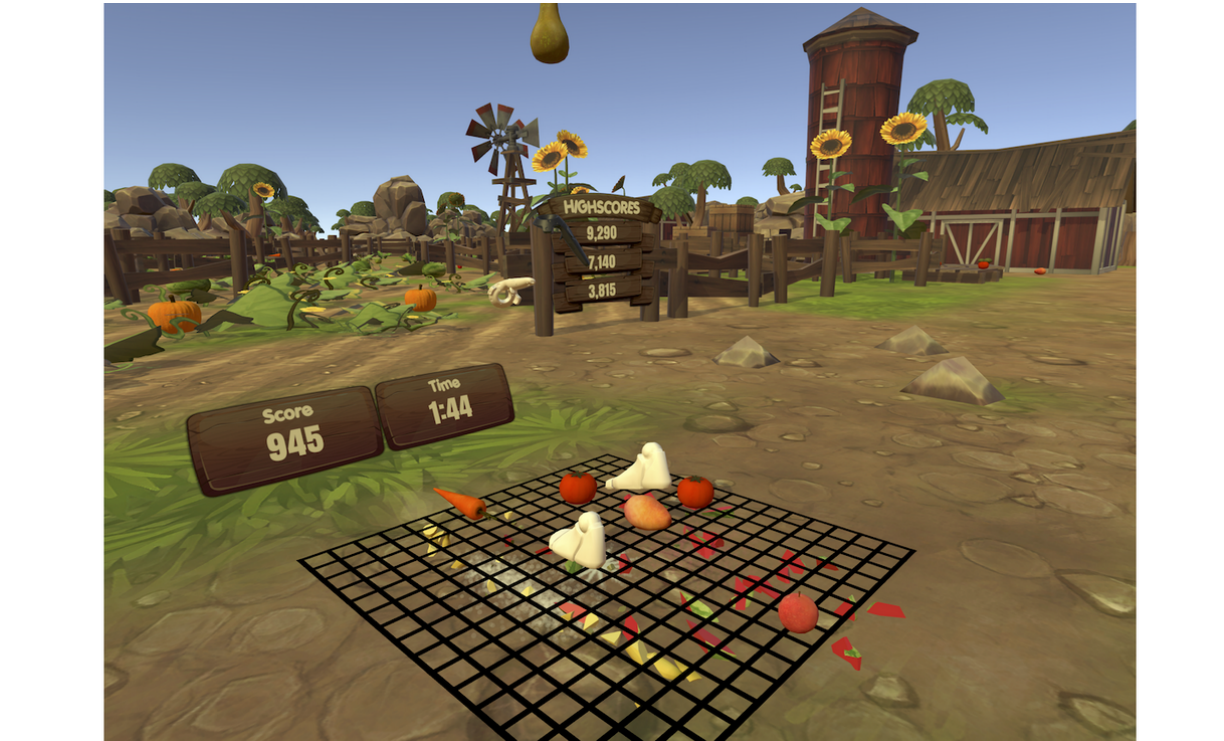
Figure 3. Fruity Feet Gameplay. The player embodies the avatar feet and hands, using them to squish virtual fruit. The player must stomp on as much fruit as possible before the timer runs out. Players are awarded points based on how quickly and effectively they stomp on the fruit. Their score is tracked in real-time and they can keep track of previous high scores to try and beat their old records. The virtual world is built to look as if players are on a farm to further immersion and provide an engaging game